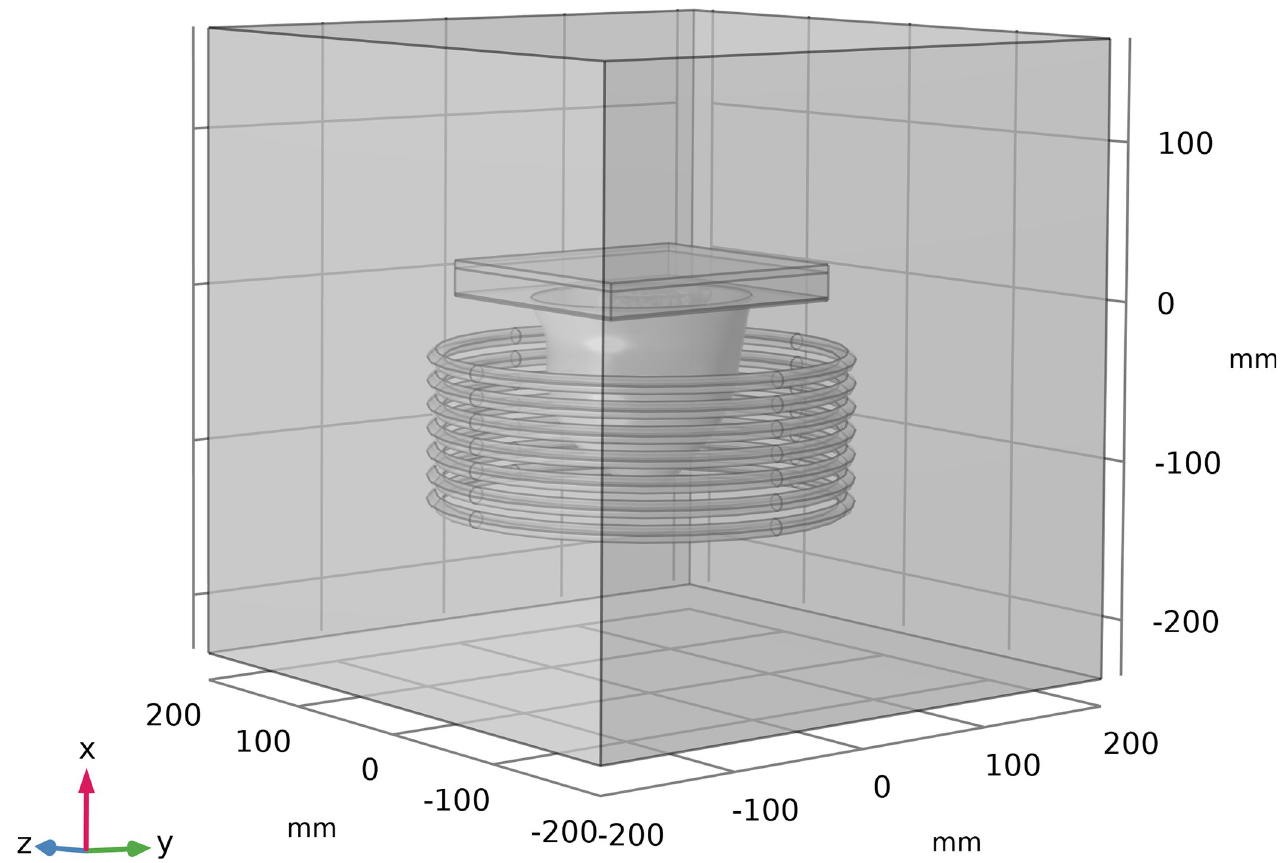
Fig 2. 3D presentation of the whole considered model